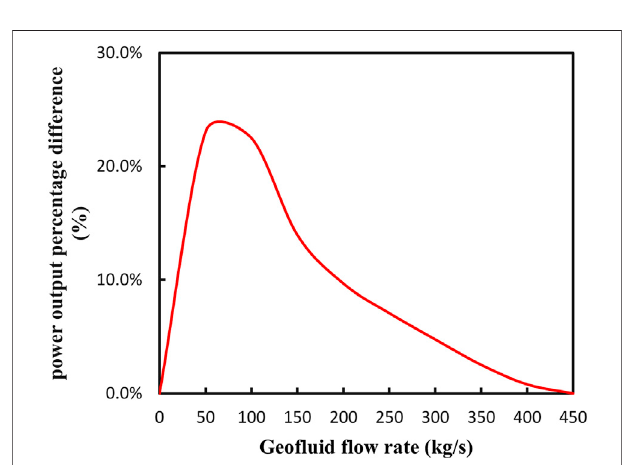
Frontiers in Energy Research |